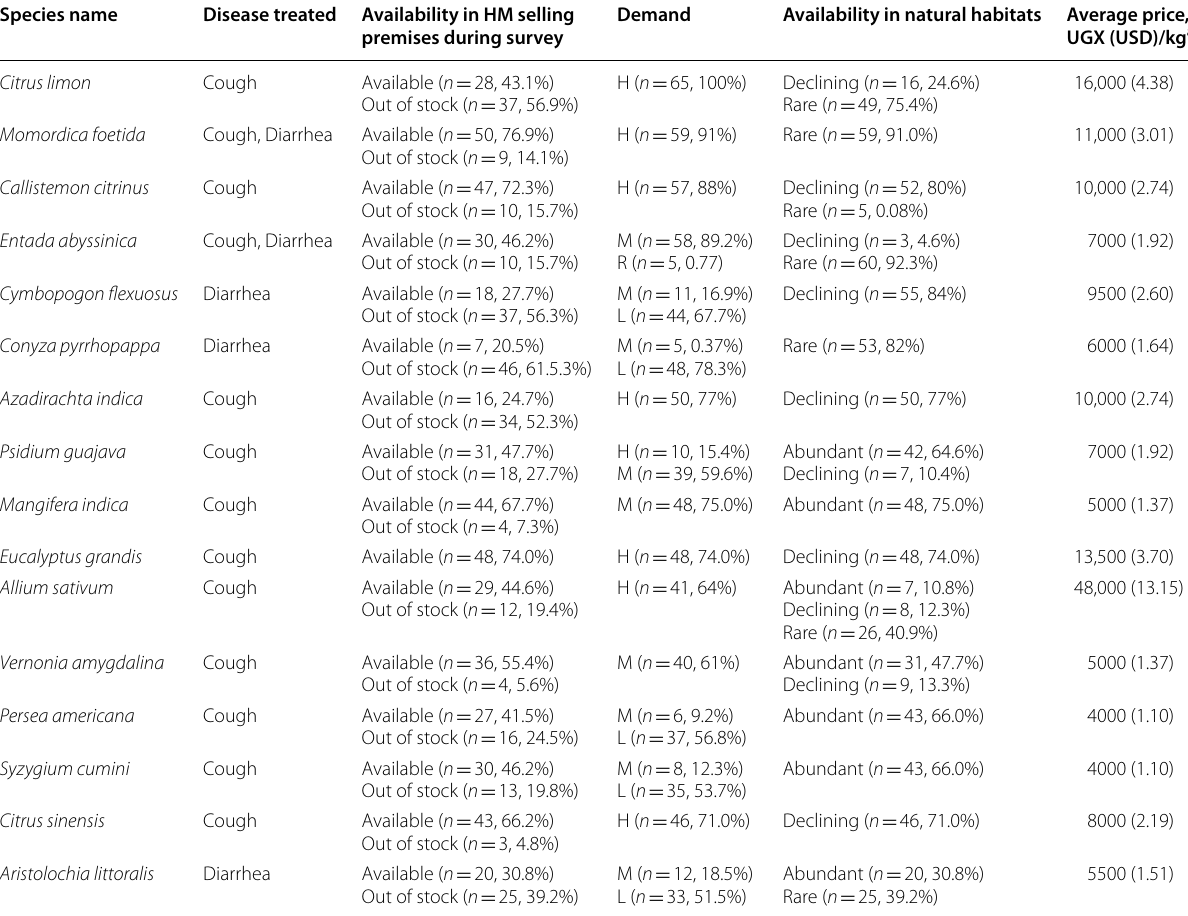
Table 4 Availability, demand and prices of frequently traded diarrhea and cough herbals in Kampala ( N